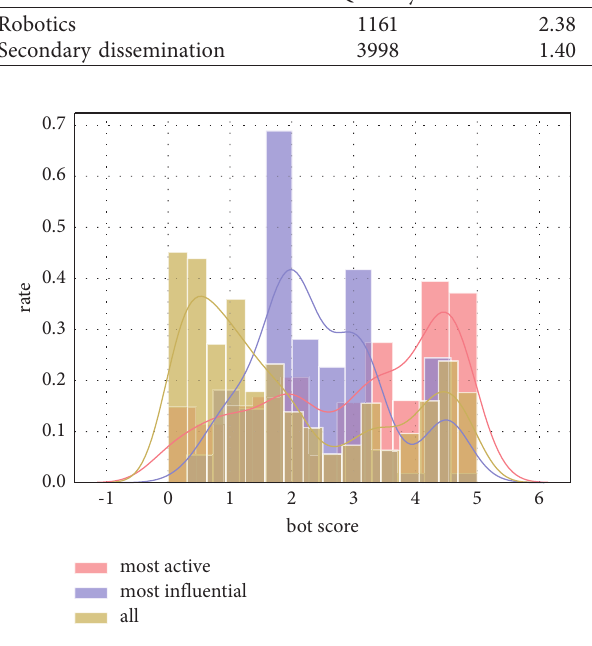
Figure 6: Distribution of bot scores of the most active users, most influential users and all users at the first level of communication.